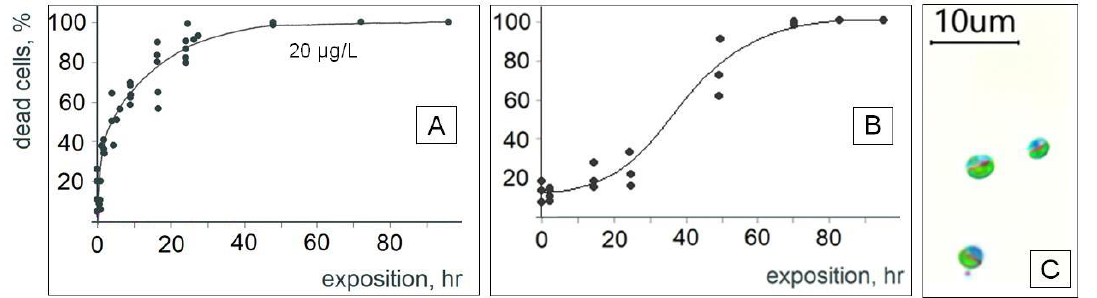
Figure 4. Cell death curves. ( A )– Lubomirskia baikalensis dead SA1-cell percentages increase in depen- dence on duration of 20 µ g L − 1 linear alkylbenzene sulfonates exposure; ( B )– Chlorella sp. dead cell percentages increase in dependence on duration of 20 µ g L − 1 LAS exposure; ( C )–dead symbiotic Chlorella sp. cells stained with methylene blue for 72 h